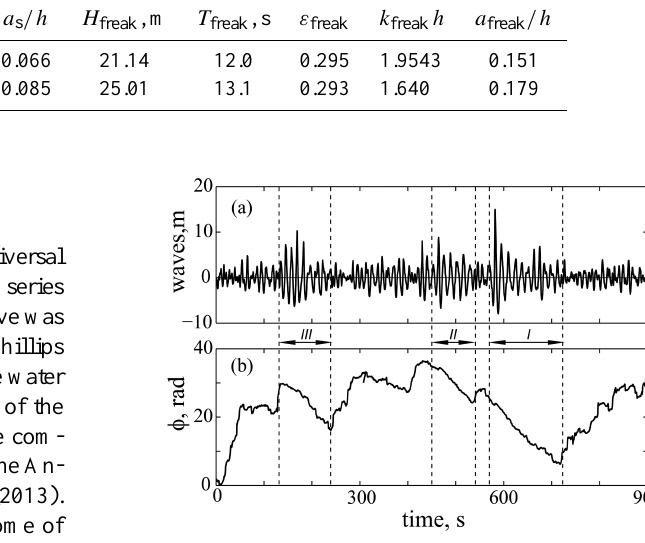
groups are separated from the rest of the series by vertical dashed